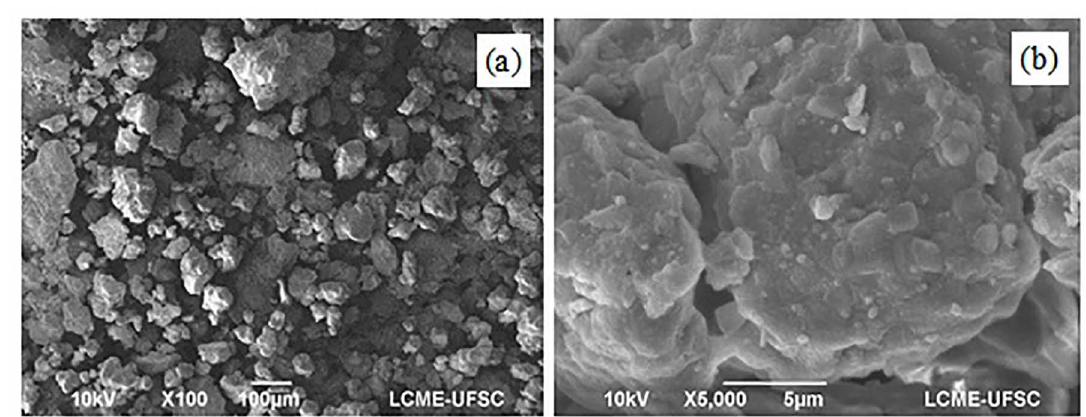
Figure 1. SEM analysis for Li